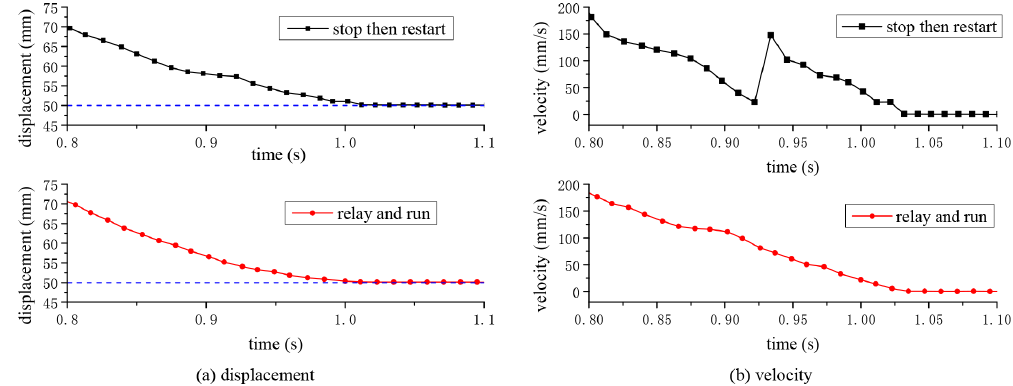
Figure 23. Comparison of the positioning test of 500–50mm with the strategies of relay and run and stop then restart.